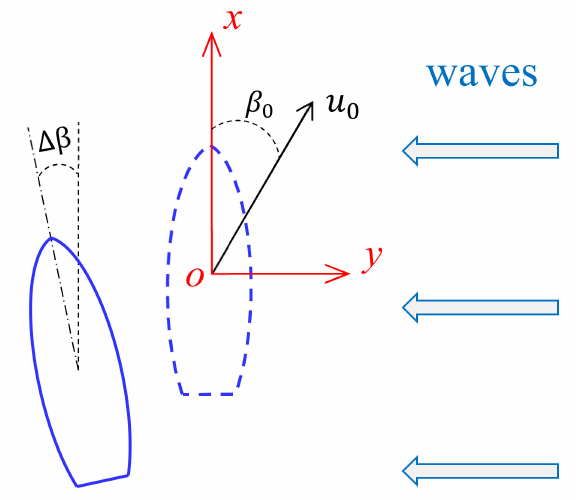
Figure 1. Illustration of a ship towed obliquely in regular beam